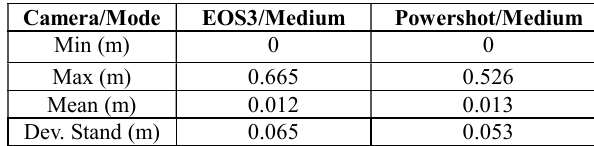
Table 4: Statistical values of the comparisons between the TLS data and the point clouds Medium.